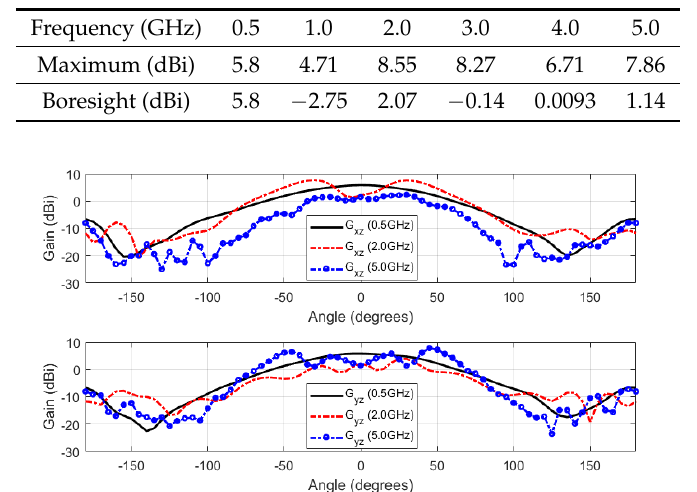
Table 2. Maximum and boresight measured total gain.